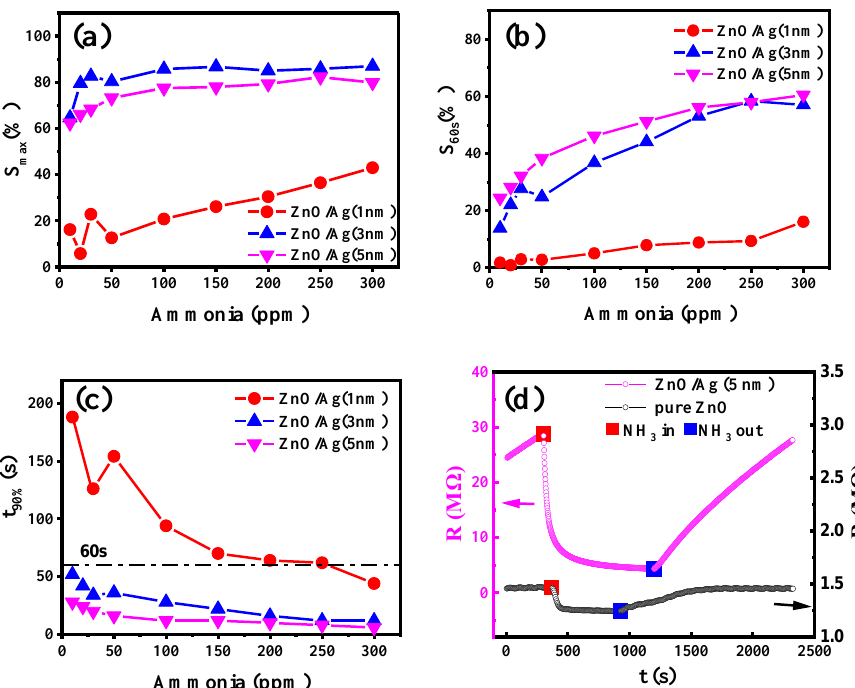
Figure 8. Sensing performance of nanostructured films with 1, 3, and 5 nm of Ag exposed to 10–300 ppm NH 3 : ( a ) maximum gas response of different Ag/ZnO films; ( b ) gas response of different Ag/ZnO films exposed to NH 3 for 60 s; ( c ) response time for the resistance to drop to 90% of the initial value; ( d ) sensing performance of ZnO films with 5 nm of Ag exposed to 300 ppm NH 3 , compared to pure ZnO.